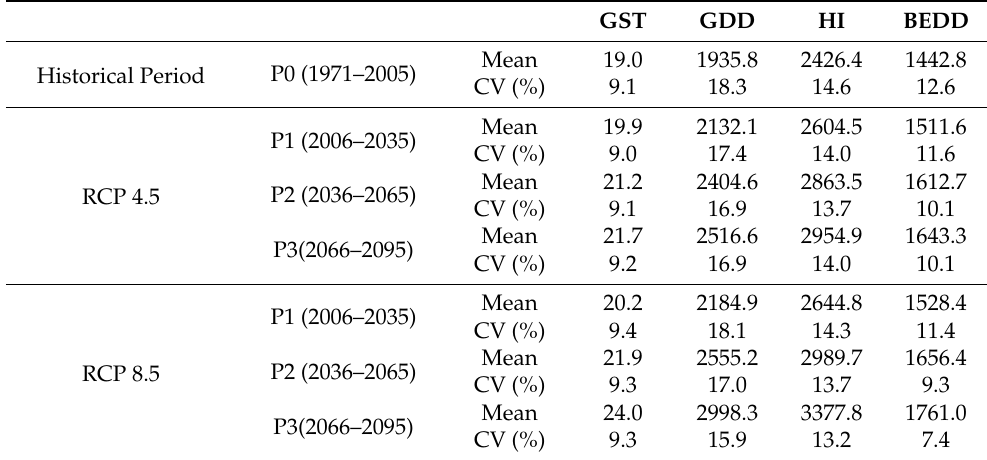
Table 3 outlines the mean indices for both the historical period, P0, and the three future periods, P1, P2, and P3, for both scenarios considered in the present study. Table 3. Mean and coefficient of variation for each bioclimatic index ( ◦ C units) and for each period and scenario.